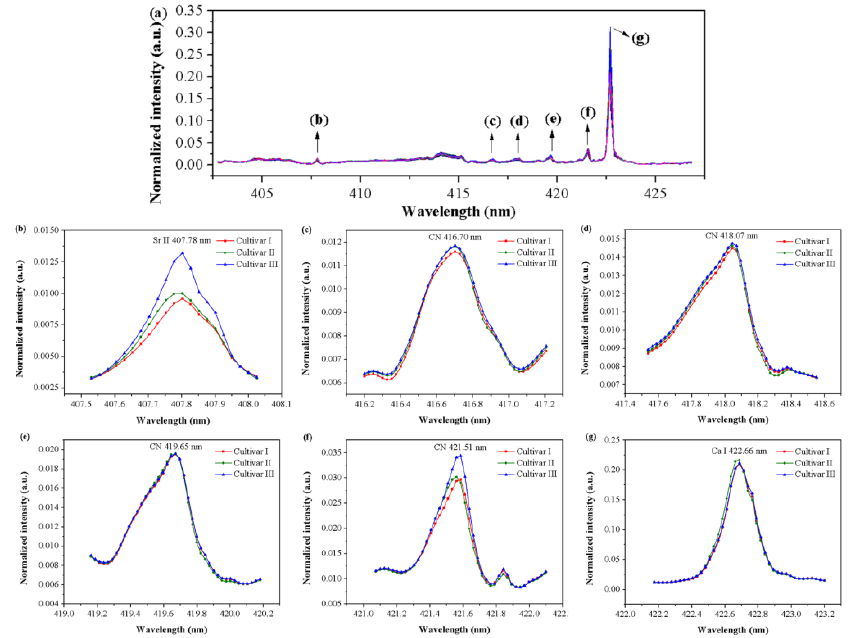
Figure 5. ( a ) The spectral region (402.74–426.87 nm) selected by interval partial least squares ( i PLS) and the average spectra near emission lines at ( b ) 407.78 nm, ( c ) 416.70 nm, ( d ) 418.07 nm, ( e ) 419.65 nm, ( f ) 421.51 nm, and ( g ) 422.66 nm. The spectra near the emission lines represent the average spectra of each cultivar in the calibration set.